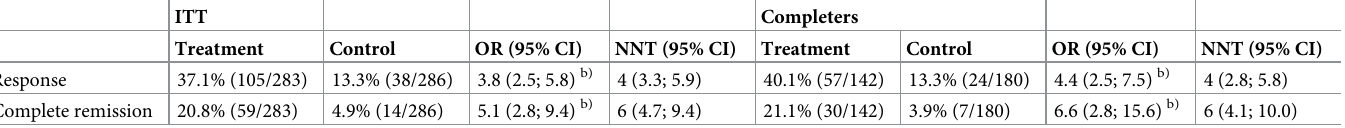
Table 4. Response and complete remission rates a